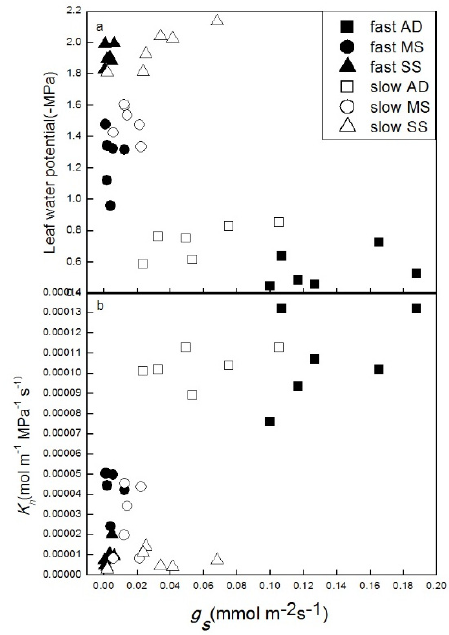
Figure 6. Stomatal conductance ( g s ) as a function of leaf water potential ( ψ leaf ) ( a ) and hydraulic conductance ( K h ) ( b ) for control (AD) and stress treatments (MS—moderately water-stressed; SS—severely water-stressed) of fast-growing and slow-growing poplar genotypes (I-101 ( Populus alba L.) × 84K ( Populus alba L. × Populus glandulosa Uyeki)) after 30 days of water stress. Water potential measurements were conducted immediately after measurements of leaf gas